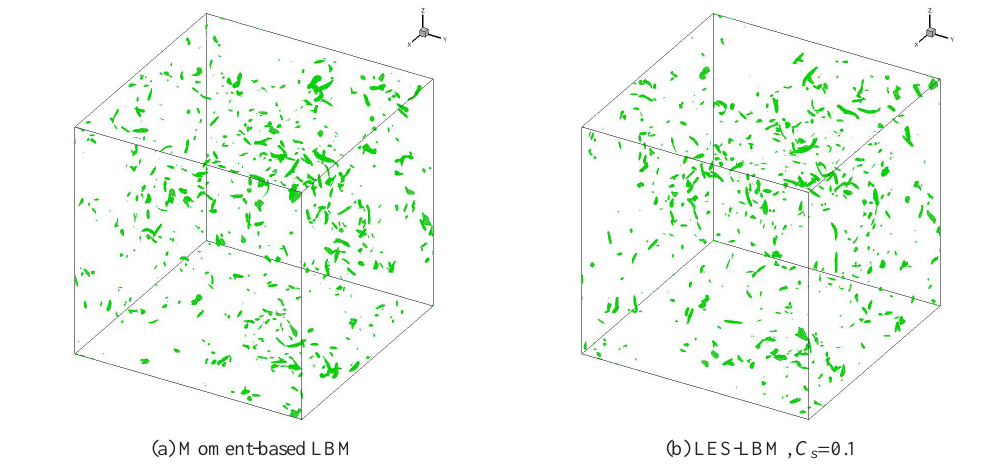
Fig. 13 Vorticity magnitude ω comparison for Re λ = 314 at t =